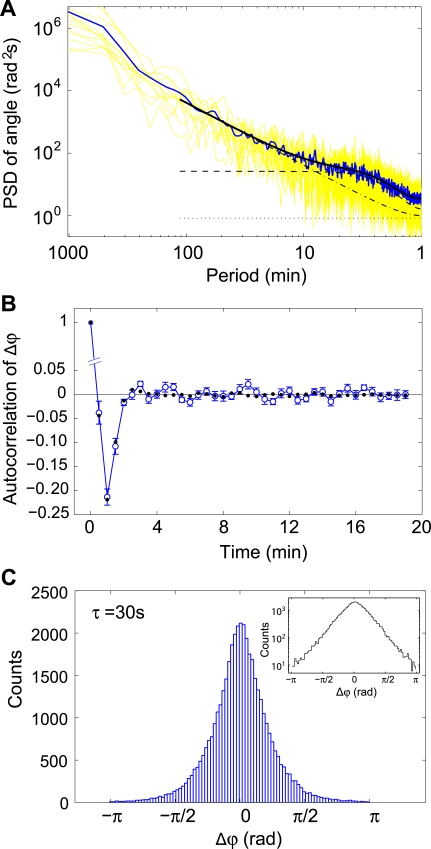
Statistics of the cumulative angles and fit to the theory.(A) Experimental power spectral density (PSD) of ϕ and fit of the theory to the data. Two time-scales were returned by the fit: (f
0)−1 = 2.35±0.08 min and 1 rad2/D
θ = 7.6±0.3 min, approximately the duration of a pseudopod and the time it takes for a cell to lose its sense of direction, respectively. Twelve individual PSDs, one for each cell, are shown in yellow. The average over the cells is shown in blue. The solid black line is a fit of the theory to the averaged signal. Dashed, dash-dotted, and dotted lines indicate the contribution to the PSD for the colored noise, the random walk, and the tracking-error terms, respectively (see Materials and Methods for details). (B) Autocorrelation function for Δϕ. ϕs were calculated for τ = 30 s. Blue: Experimental values and standard errors. Black: Theoretical expectation value calculated from a Monte Carlo simulation on ϕ based on Eqs. 1–3, with parameters obtained from a fit to the PSD. (C) Experimental histogram of Δϕs calculated for τ = 30 s. Insert: Same histogram shown on a semi-logarithm scale demonstrating the non-Gaussian, exponential tails. With increasing τ, the distribution of Δϕ becomes more and more Gaussian (data not shown).